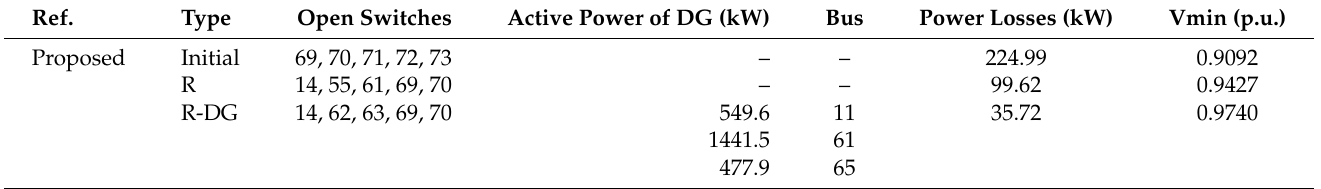
Table 10. Comparative analysis of reconfiguration with distributed generation for the 69-bus test system.